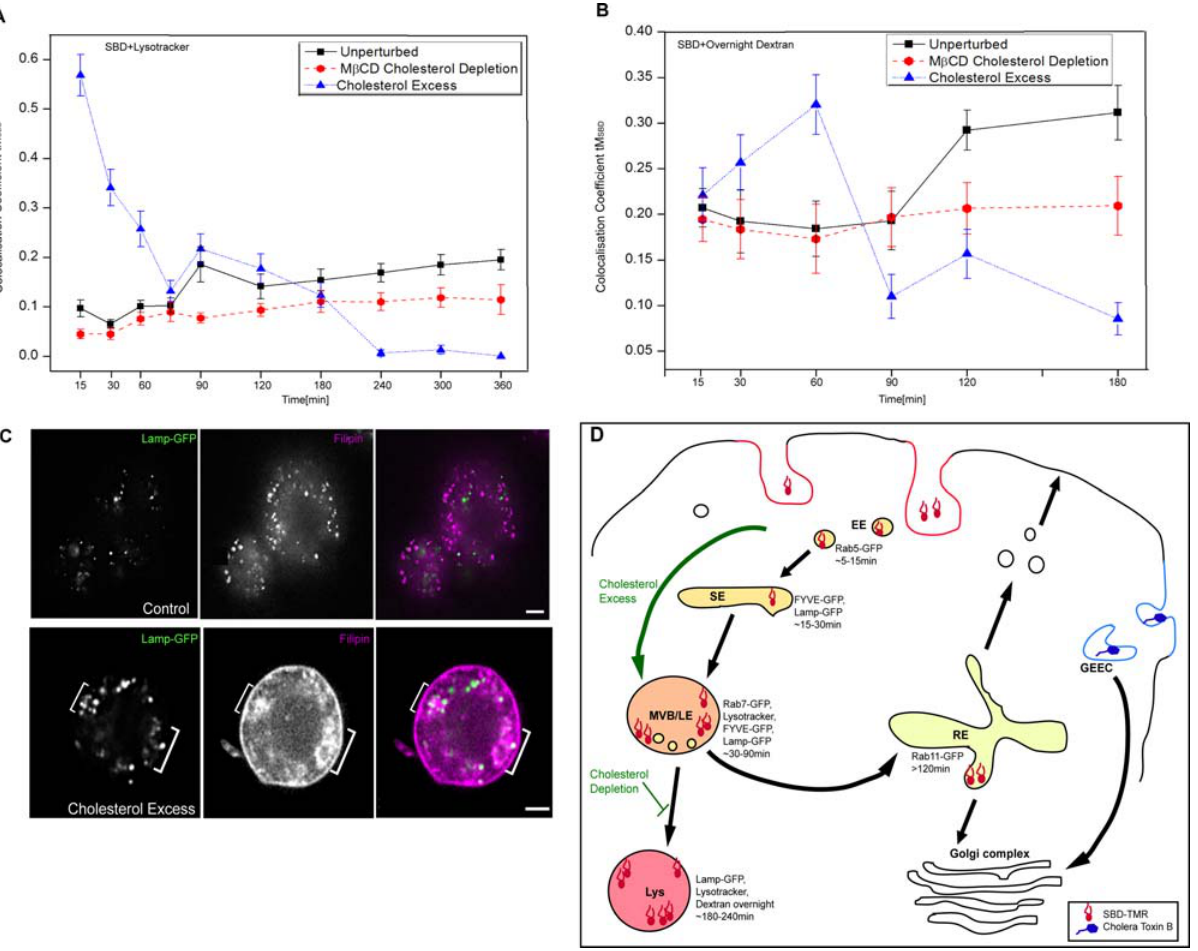
Figure 9. SBD trafficking to acidic organelles is sensitive to cholesterol levels. A. C6 cells depleted of cholesterol with M b CD (10 mM 30 min 25 u C; red circles) or treated with excess cholesterol (10 mM M b CD-10mM cholesterol complexes for 30 min 25 u C; blue triangles), or untreated (black squares), then labeled with lysotracker and pulsed with SBD-OG. Colocalization (tM SBD ) was calculated at the given time points of chase. Data for control untreated cells were compiled from two experiments. B. C6 cells were labeled with Dextran-Alexa488 overnight, and then depleted of cholesterol (red circles), or treated with excess cholesterol as in (A)(blue triangles), or untreated (black squares) and labeled with SBD-TMR, as in fig. 5F. Colocalization was calculated at the given time points of chase. C. Control c6 cells (top panels), or c6 treated with excess cholesterol (bottom panels) after transfection with LAMP-GFP (green) and subsequent fixation show heavy accumulations of filipin (pink) at the plasma membrane and near, but not exclusively in, endolysosomal compartments (brackets). Total cholesterol content after cholesterol overloading was increased by 250%, 6 13% (n=3; quantification by Amplex Red enzymatic assay not shown). Scale bars for all images=5 m m. D. Schematic representation of the internalization pathway of fluorescent SBD (red shapes) vs. another lipid-raft associated cargo, CtxB (blue hexagons), which is taken up by the GEEC pathway [11]. Cholesterol depletion moderately inhibited transport of SBD through a Dextran-positive lysosomal compartment ( . 90 min in graph B), whereas cholesterol excess led to premature accumulation and then clearing of SBD from lysotracker- and Dextran-positive acidic compartments. Detection of myc immunoreactivity indicates that internalized SBD-myc has not been degraded. Dot blots were also exposed to anti- b -tubulin as a loading control to ensure that protein amounts were comparable in the various sets. Intensity of dots was quantified using Quantity One software and represented in bar graphs.